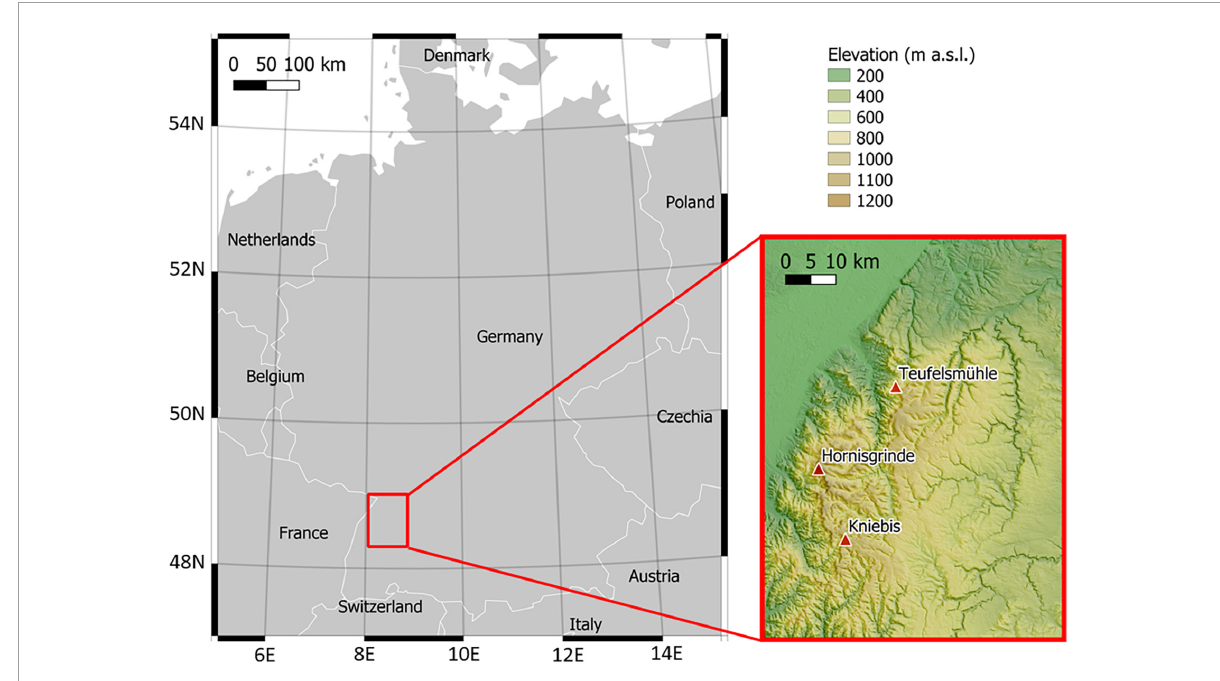
FIGURE1 Location of the study region in Southwestern Germany with the three established elevational transects in the Black